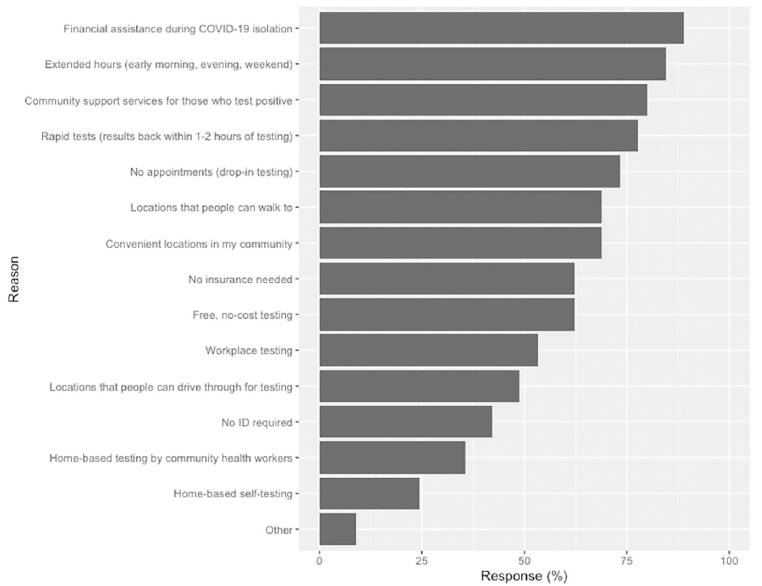
Fig 1. Facilitators to COVID-19 testing identified by participants in the tri-county Latino COVID-19 Collaborative (N = 45 participants responding to baseline survey) in January